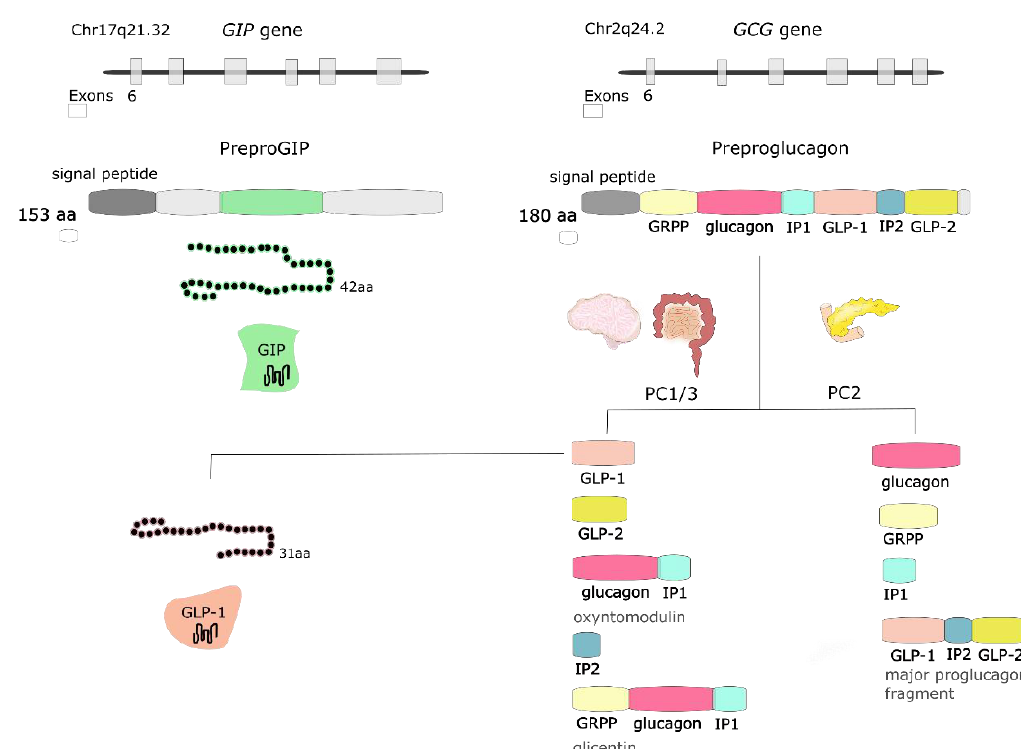
Figure 2. The GIP gene is localized on human chromosome Chr17q21.32 and encodes 153-amino acid (aa) proprotein, which is processed to 42-aa protein glucose-dependent insulinotropic peptide (GIP). GCG gene is localized on human chromosome Chr2q24.2 and encodes preproglucagon—180-aa protein, which undergoes differential posttranslational processing in a particular type of cell. Proteolytic processing of proglucagon by prohormone convertase 1/3 (PC1/3) in the intestine generates glucagon-like peptide 1 (GLP-1), glucagon-like peptide 2 (GLP-2), oxyntomodulin, intervening peptide 2 (IP2) and glicentin. Prohormone convertase 2 (PC2) activity in the pancreas forms glucagon, glicentin-related pancreatic polypeptide (GRPP), intervening peptide 1 (IP1), and major proglucagon fragment.